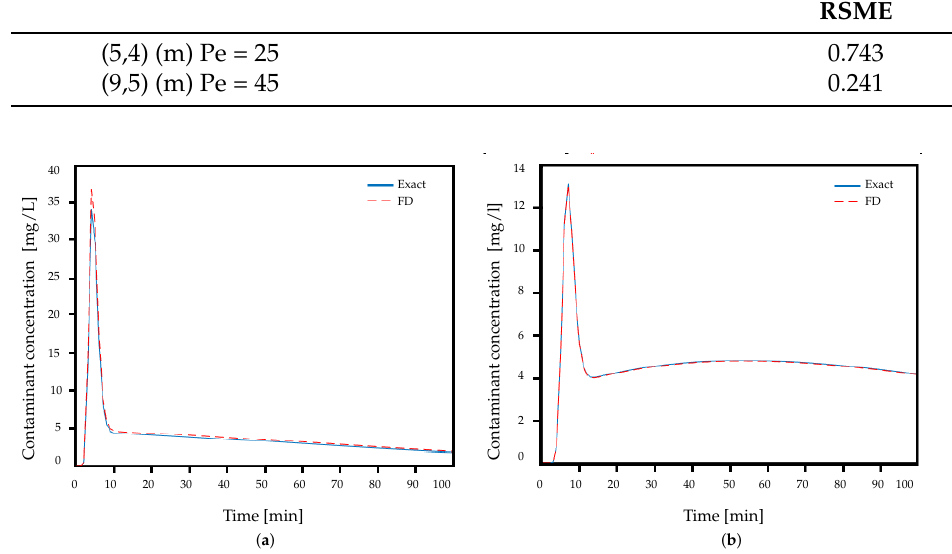
Figure 6. Contaminant concentration profile at: ( a ) (5,4) m Pe = 25 , ( b ) (9,5) m, Pe = 45.